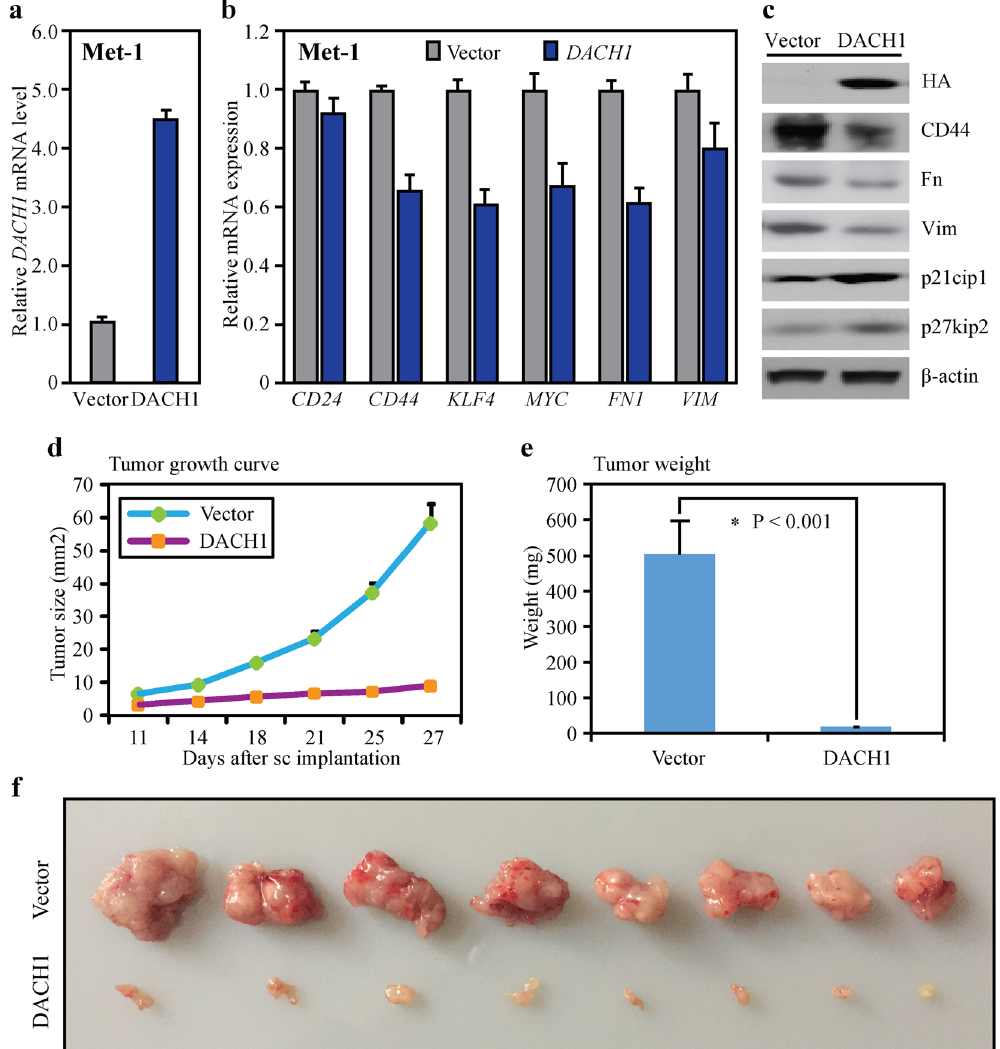
Figure 3. DACH1 regulated the expression of some CSCs and EMT genes in Met-1 cells and suppressed tumor growth in vivo . ( a ) Stable expression of DACH1 in breast cancer Met-1 cells was achieved by retrovirus infection. ( b ) RNA microarray and cluster analysis showed that upregulation of DACH1 reduced the mRNA levels of CD24 , CD44 , KLF4 , MYC , FN1 and VIM in Met-1 cells. ( c ) Western blot indicated that upregulation of DACH1 reduced the protein abundance of CD44, Fibronectin, Vimentin, p21 and p27 in Met-1 cells. ( d ) DACH1 overexpression significantly reduced the volume of tumors by ∼ 90% and slowed down the speed of tumor growth in nude mice xenograft tumors. ( e ) Overexpression of DACH1 also reduced mice transplanted tumor weight by ∼ 90%. ( f ) Mammary tumor growth in vivo was evaluated by subcutaneous implantation of DACH1-overexpressing Met-1 cells and the GFP controls in nude